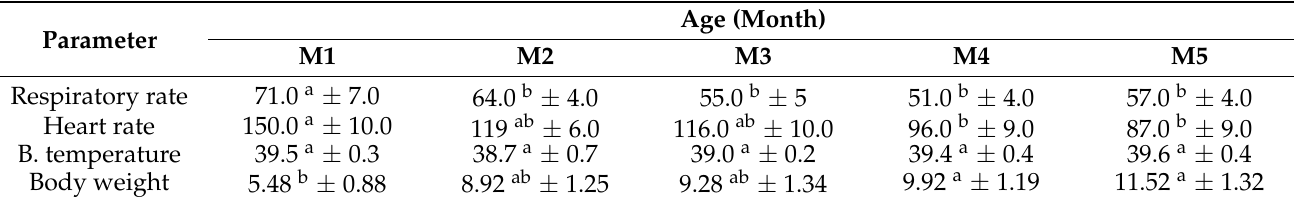
Table 3. Clinical parameters in healthy newborn kids during the first five months of